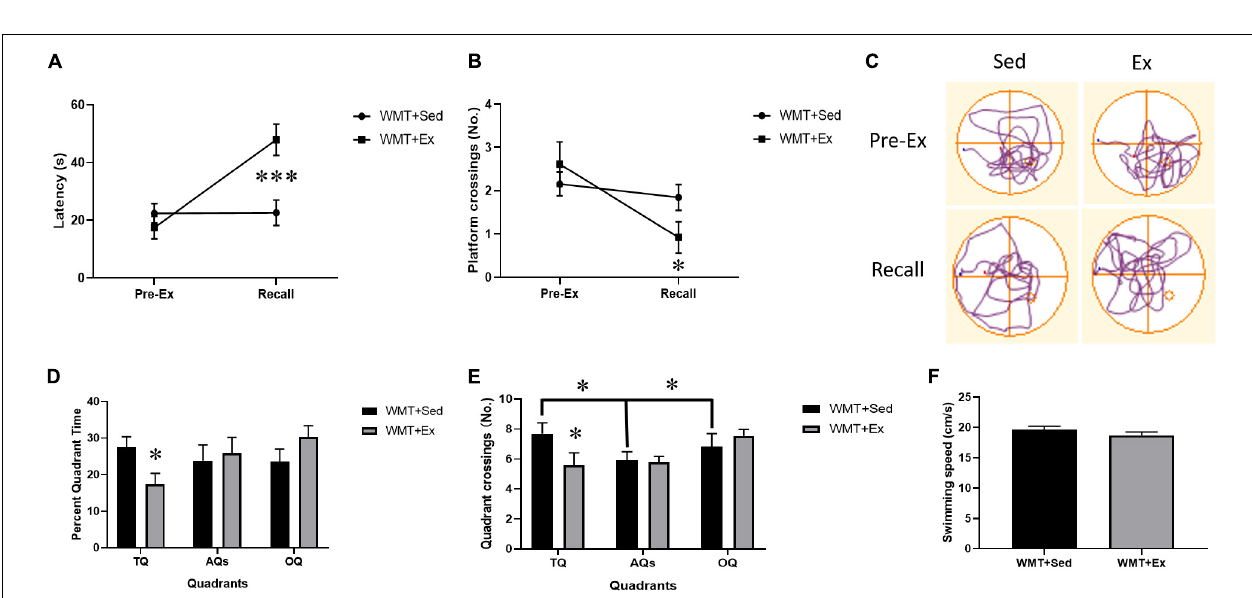
FIGURE 3 | Exercise facilitates the diminishment of acquired memory traces. (A,B) Comparison of memory retention (pre-exercise probe vs. recall) between the WMT + Sed and WMT + Ex groups after 4 weeks of housing in standard cages (Sed) or in cages equipped with a running wheel (Ex). There is a significant increase in the latency to find the platform location and decrease in the number of entries in the platform when compared with that during the pre-exercise probe test in the WMT + Ex group, whereas no significant change is detected for the WMT + Sed group. (C) Trajectories of mice exploring the maze during the pre-exercise probe and recall tests. (D) The percentage of time mice spend in different quadrants during the probe test of recall. Exercise significantly reduces mice exploration in the target quadrant (TQ) when comparing with sedentary group. No difference is found in the exploration in different quadrants (target: TQ, adjacent: AQs and opposite quadrants: OQ) for both groups. (E) The number of quadrant crossings during recall probe test. Mice in the WMT + Ex group show decreased the TQ crossings when comparing with mice in the WMT + Sed group. Mice in the WMT + Sed group exhibit more entries in the TQ than AQs and TQ. (F) Comparison of swimming speed between the WMT + Sed and WMT + Ex groups during probe test. There is no difference in the swimming speed between groups. Data are graphed as means ± SEM ( n = 13) and were analyzed using two-way repeated ANOVA (A,B) and two-way ANOVA (D, E). ∗ p < 0.05, ∗∗∗ p < 0.001.